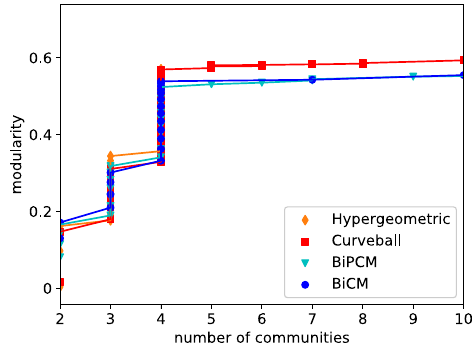
Fig. 7 Modularity vs number of communities for the best partition obtained on the validated networks. Note how the curves of the various models collapse onto each other. Besides, the growth of modularity suddenly stops at 4 communities, suggesting the presence of a robust partition shared between all null